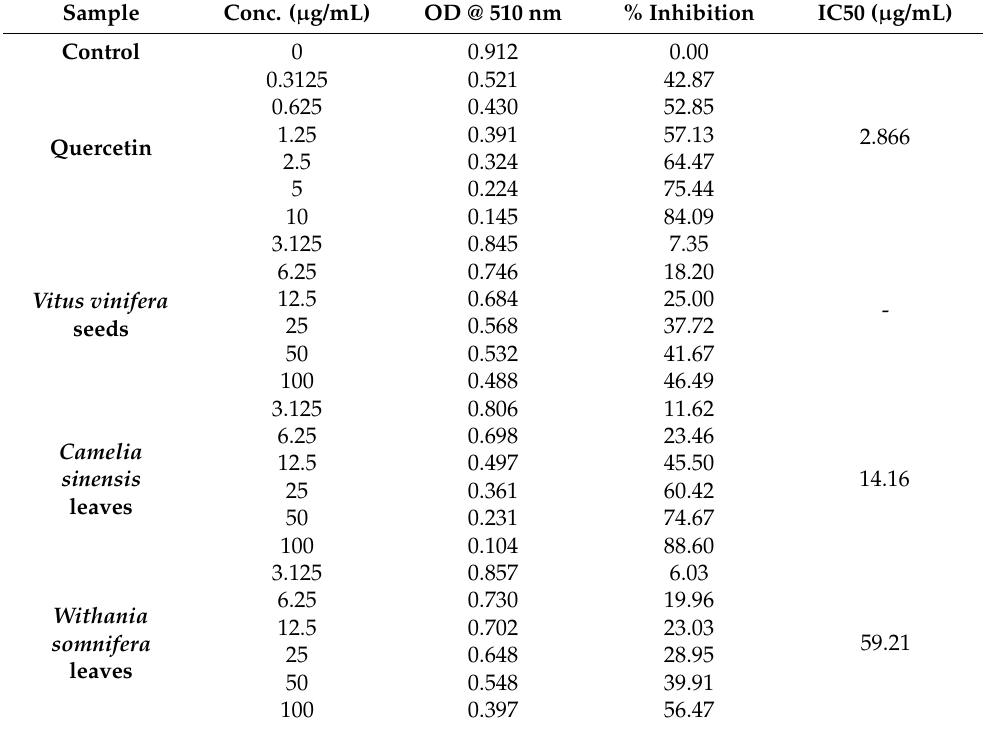
Table 3. Antioxidant activity using DPPH